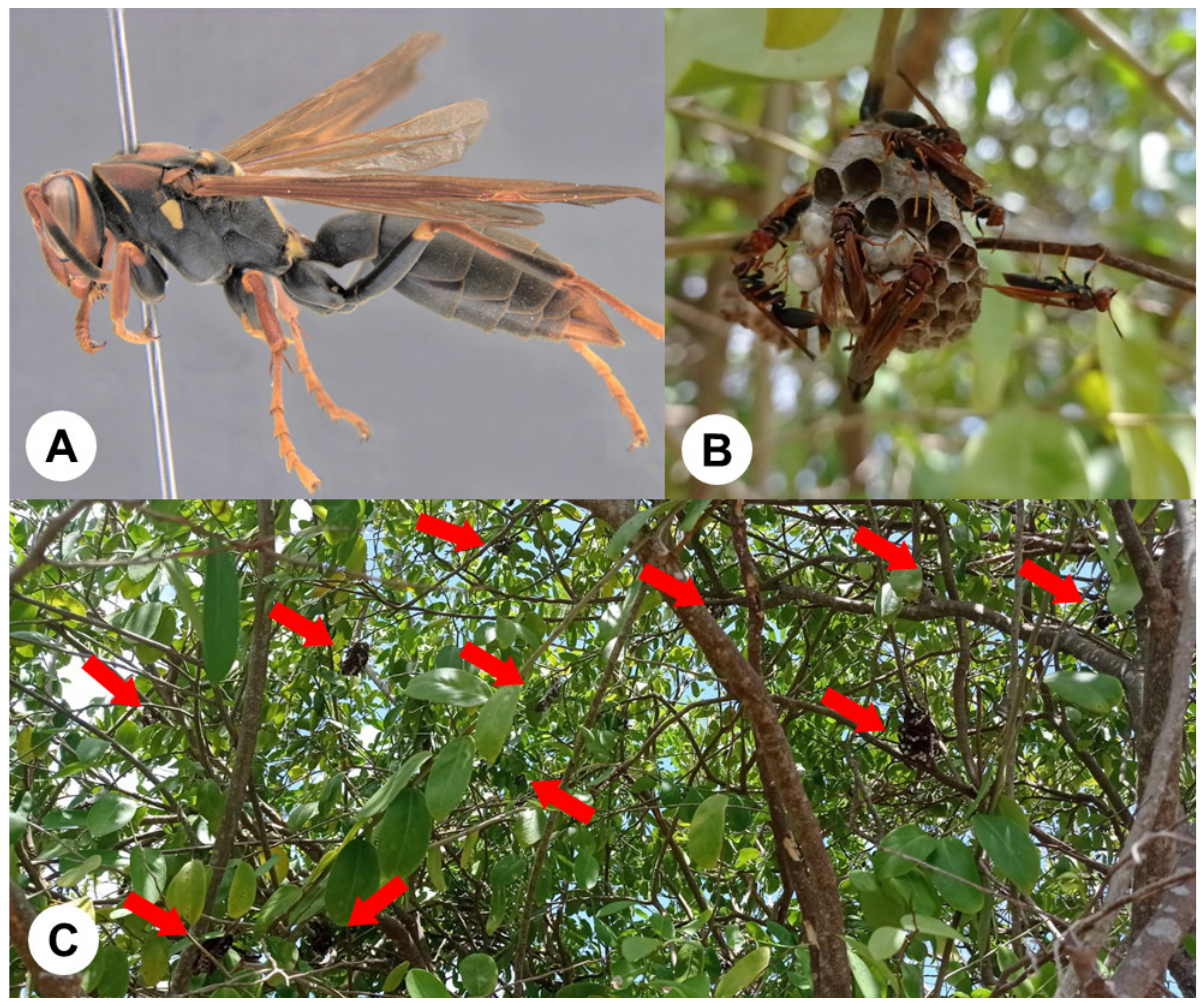
Fig 2 . A – Polistes ridleyi Kirby, 1890, in lateral view; B – Colony of P. ridleyi ; C – Red arrows showing nearby colonies on the same tree canopy Cynophalla flexuosa